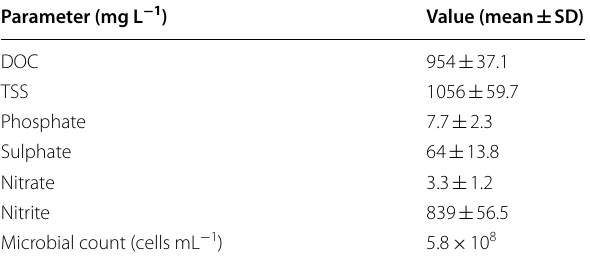
Table 1 Selected characteristics of poultry